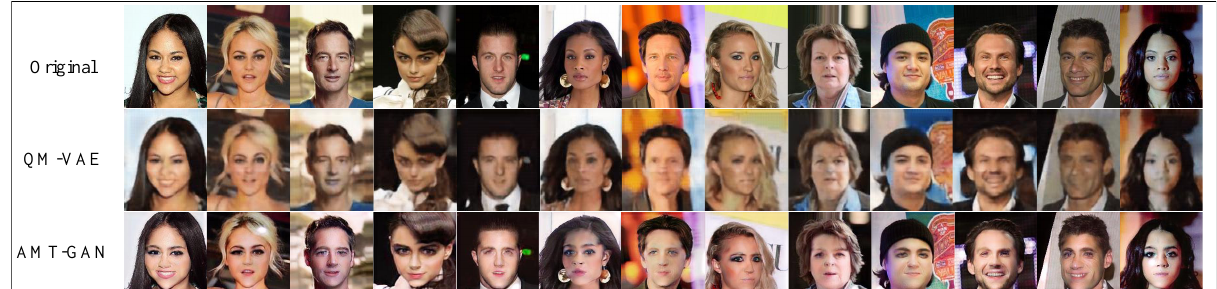
Figure 8. Comparison of the resulting images of QM-VAE and AMT-GAN.